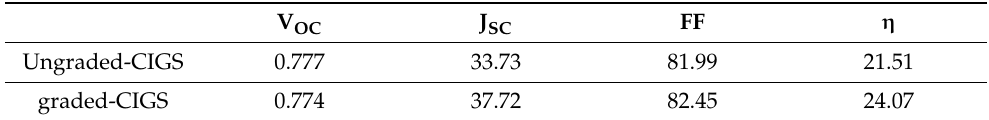
Figure 7. J–V characteristics curve of the solar cell based on graded CIGS. Table 3. Results of the performance parameters for graded CIGS compared with data of the ungraded